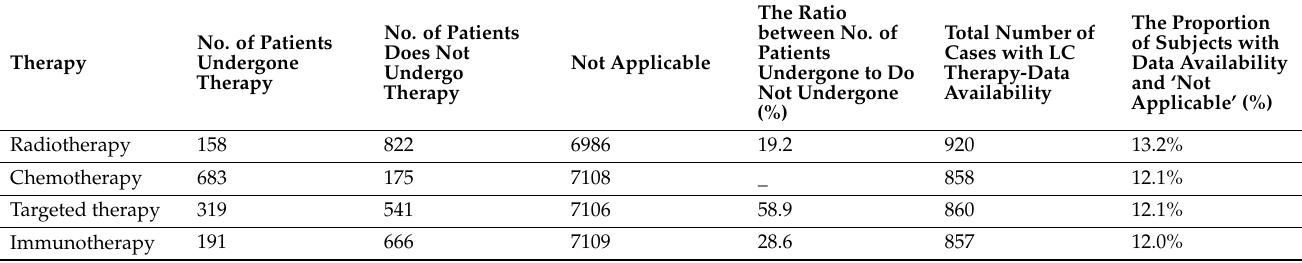
Table 1. TCGA-cBioportal data comparison on various LC therapy from 31 studies (Data